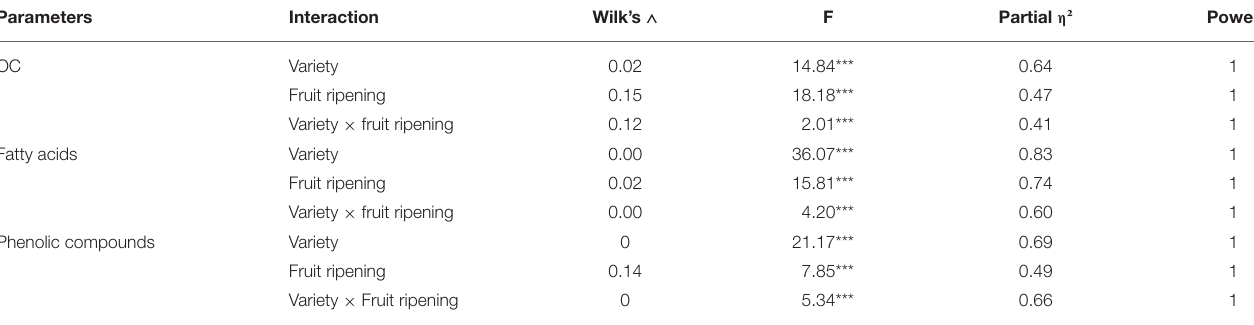
TABLE 1 | Results of the Multivariate Analysis of Variance (MANOVA) of the three sets of variables: oil content (OC), fatty acids, and phenolics composition.